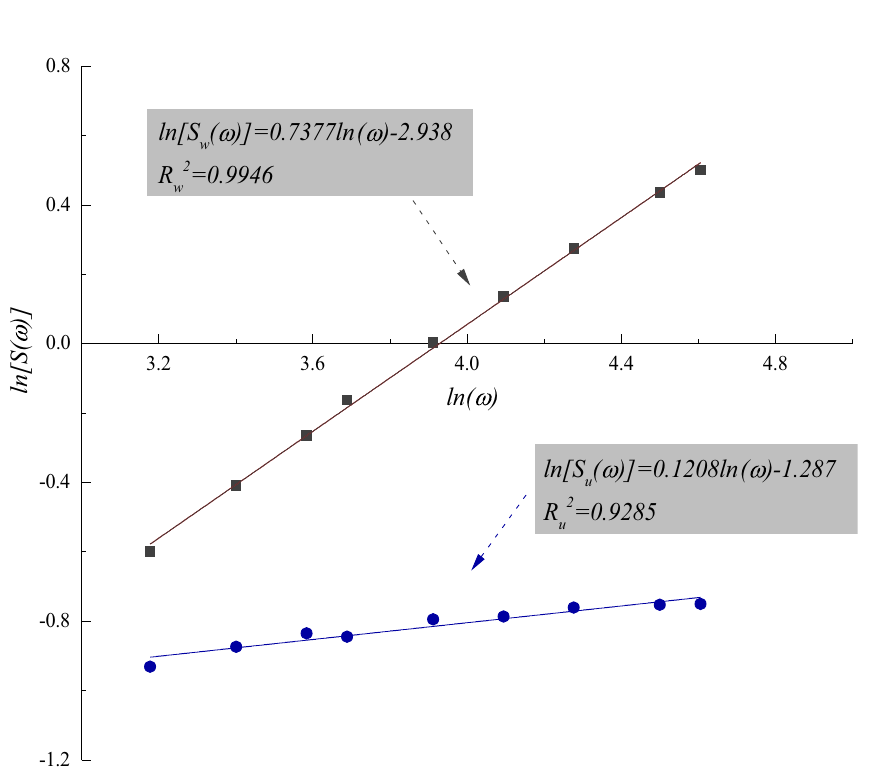
Figure 9. Double-logarithmic relationship between standard deviations of heights of two-order roughness ( S w (ω) and S u (ω) , respectively) and window length ( ω ) of the sample size of 900 mm × 900 mm of joint sample S1. D w and D u denote the fractal dimensions of waviness and unevenness, respectively. R coefficients of determination in estimating the fractal dimensions of waviness and unevenness,